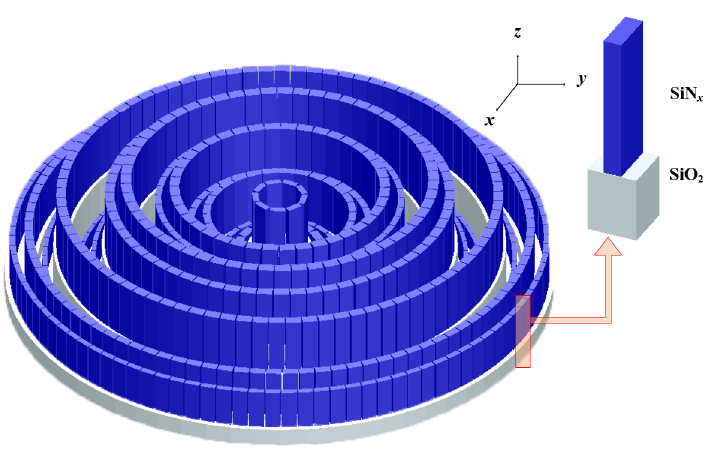
Figure 5. The three-dimensional drawing of designed